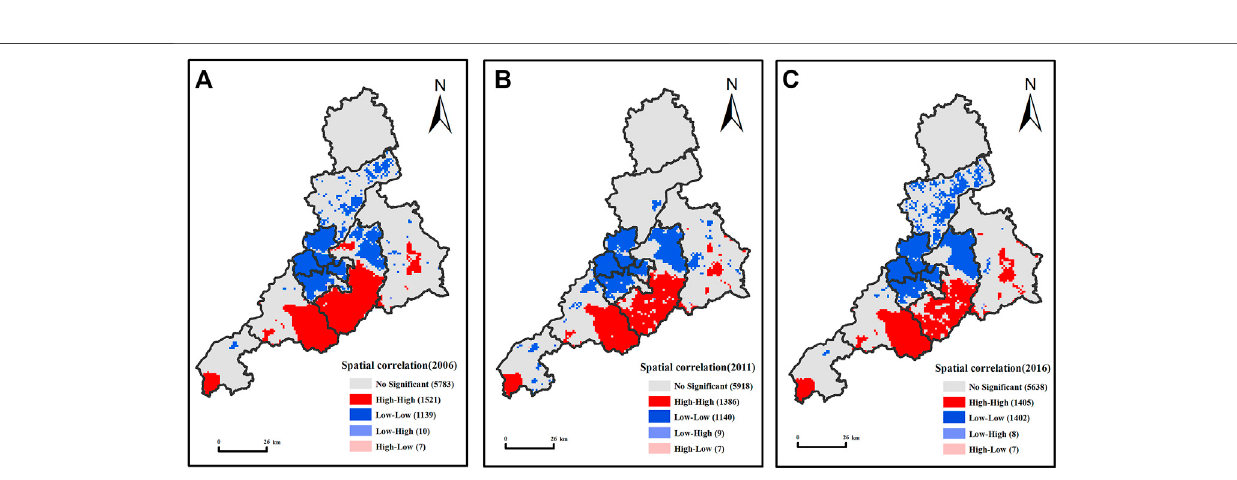
Frontiers in Environmental Science |